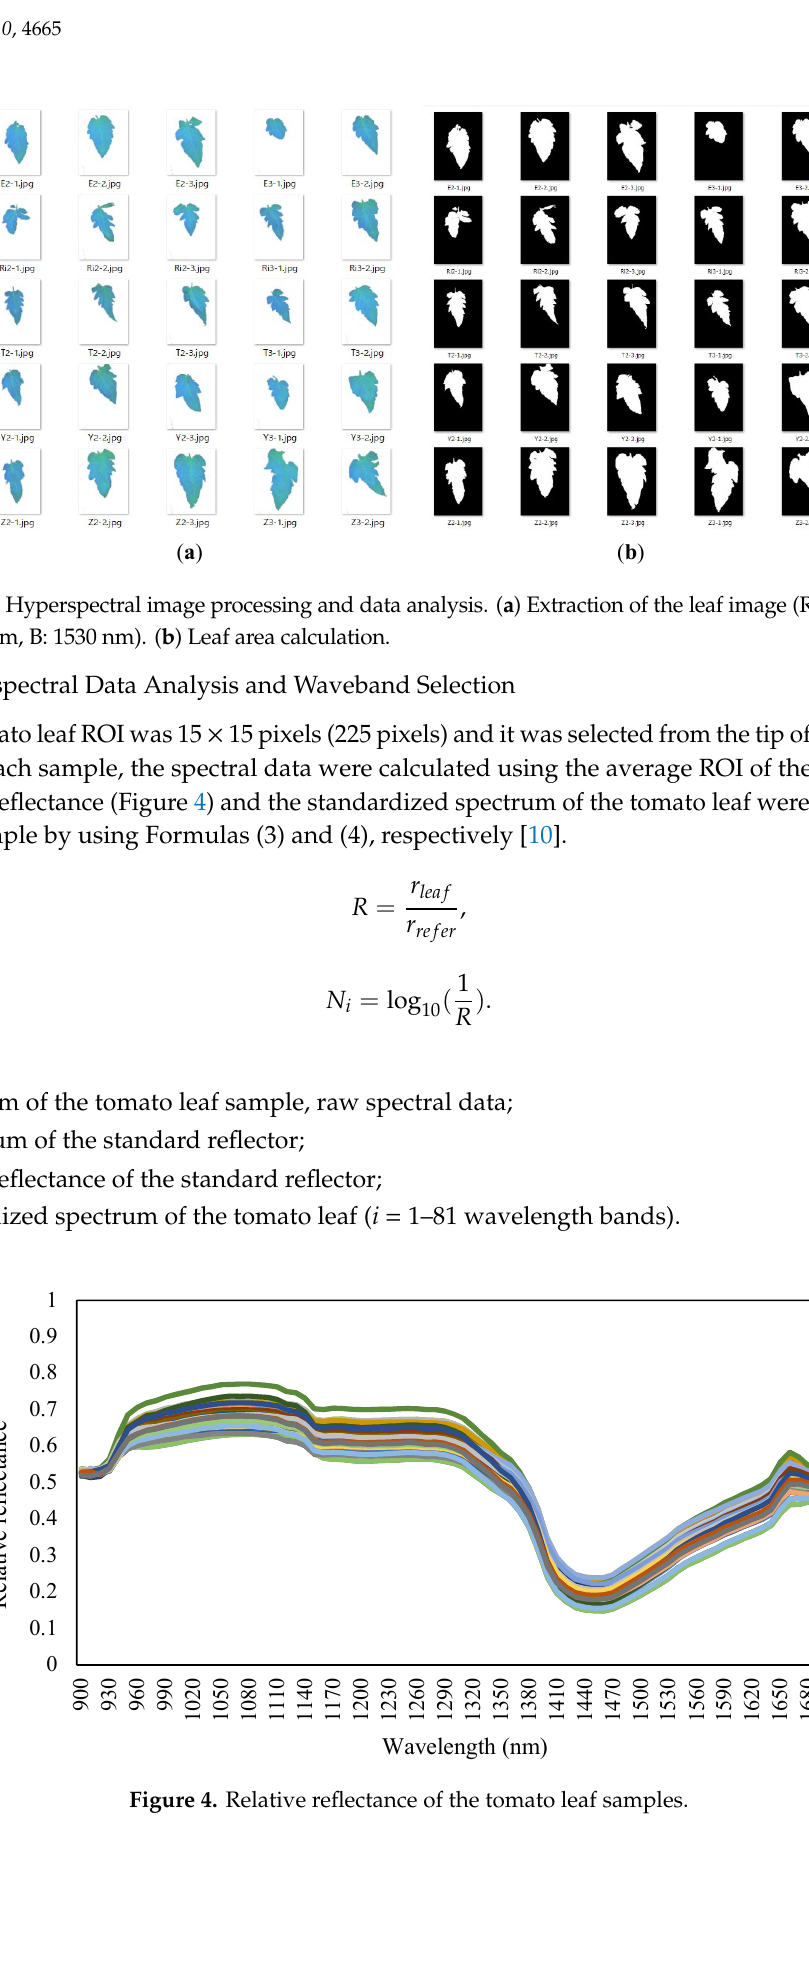
Figure 4. Relative reflectance of the tomato leaf samples.